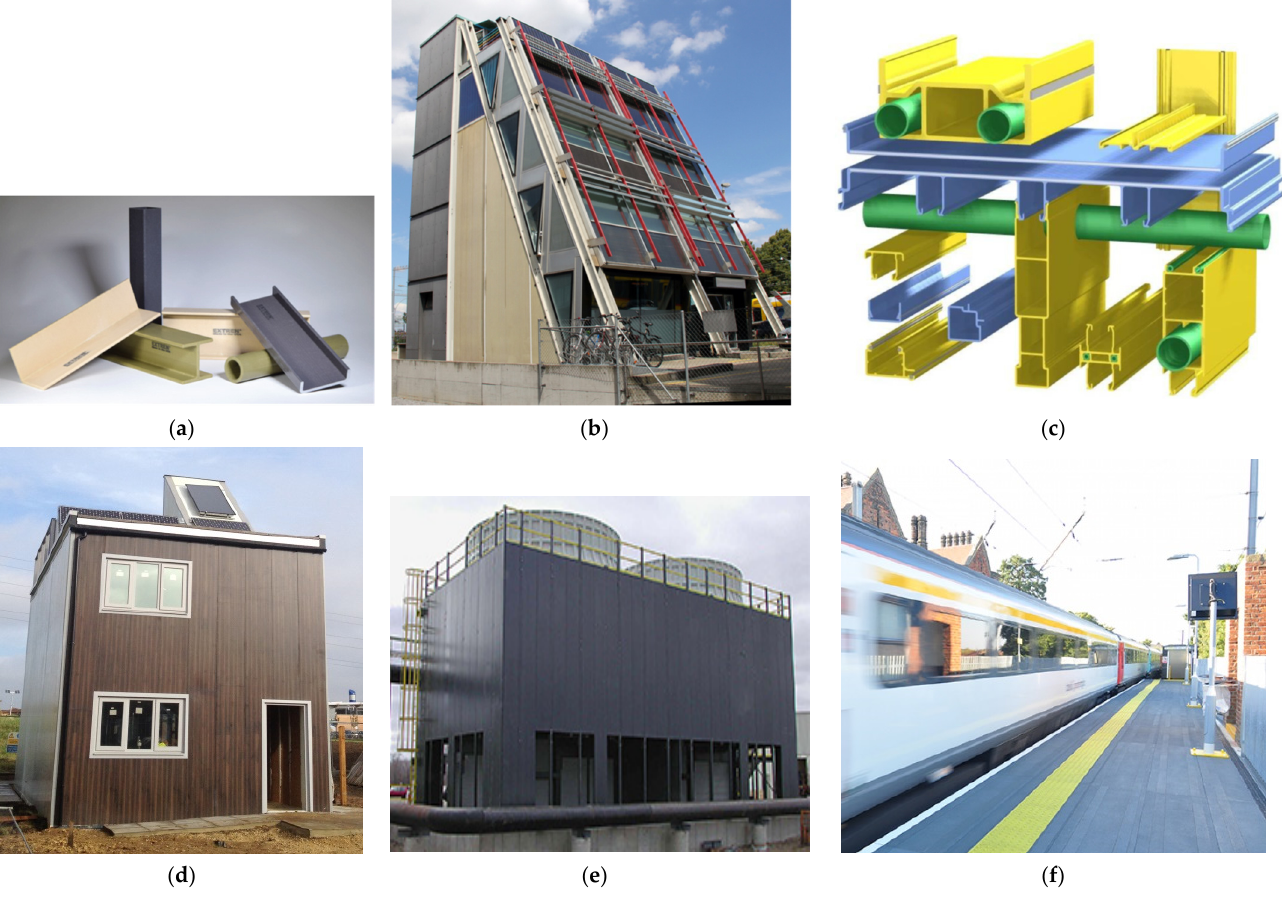
Figure 2. Applications of FRP in buildings and other structures: ( a ) Glass fibre reinforced polymer structural shapes [12]; ( b ) Five-storey Eyecatcher FRP demountable building Switzerland [31]; ( c ) Startlink test house modular pultruded FRP concept profiles [32]; ( d ) Startlink—Fully composite test house [33]; ( e ) Pultruded FRP cooling tower [12]; ( f ) Duracomposites railway platforms [34].